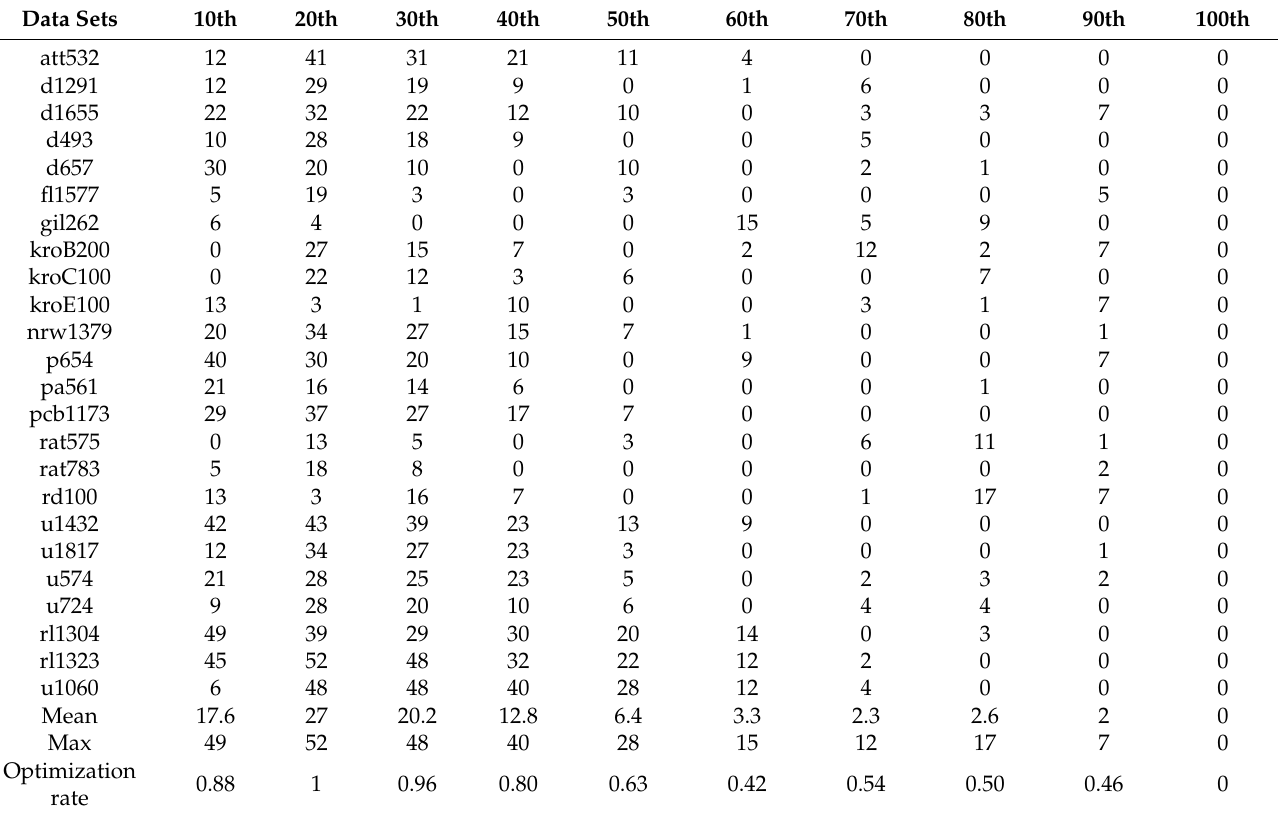
Table 4. The saving generations of SEACO algorithm than ACO algorithm on the test data sets. Data